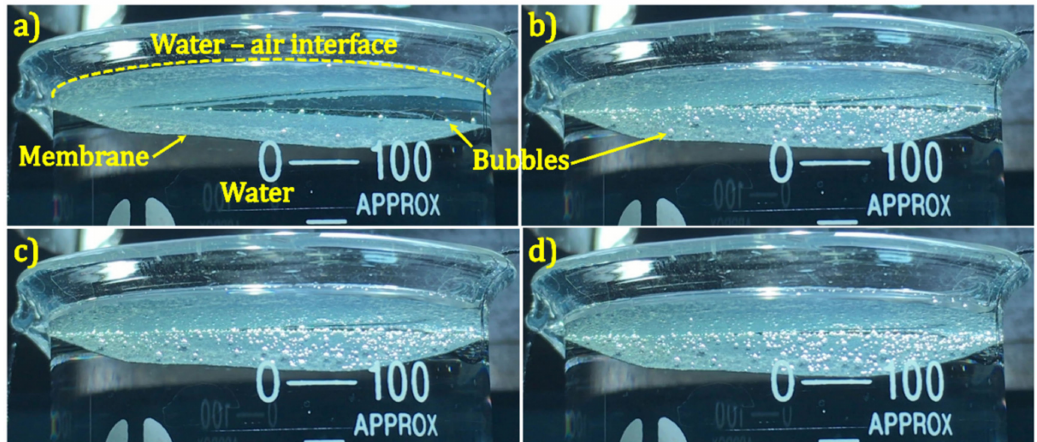
Figure 4. Bubbles generated on TiN membrane surface under continuous illumination for ( a ) 30 s, ( b ) 600 s, ( c ) 1200 s and ( d ) 1800 s. The membrane is slightly tilted for better